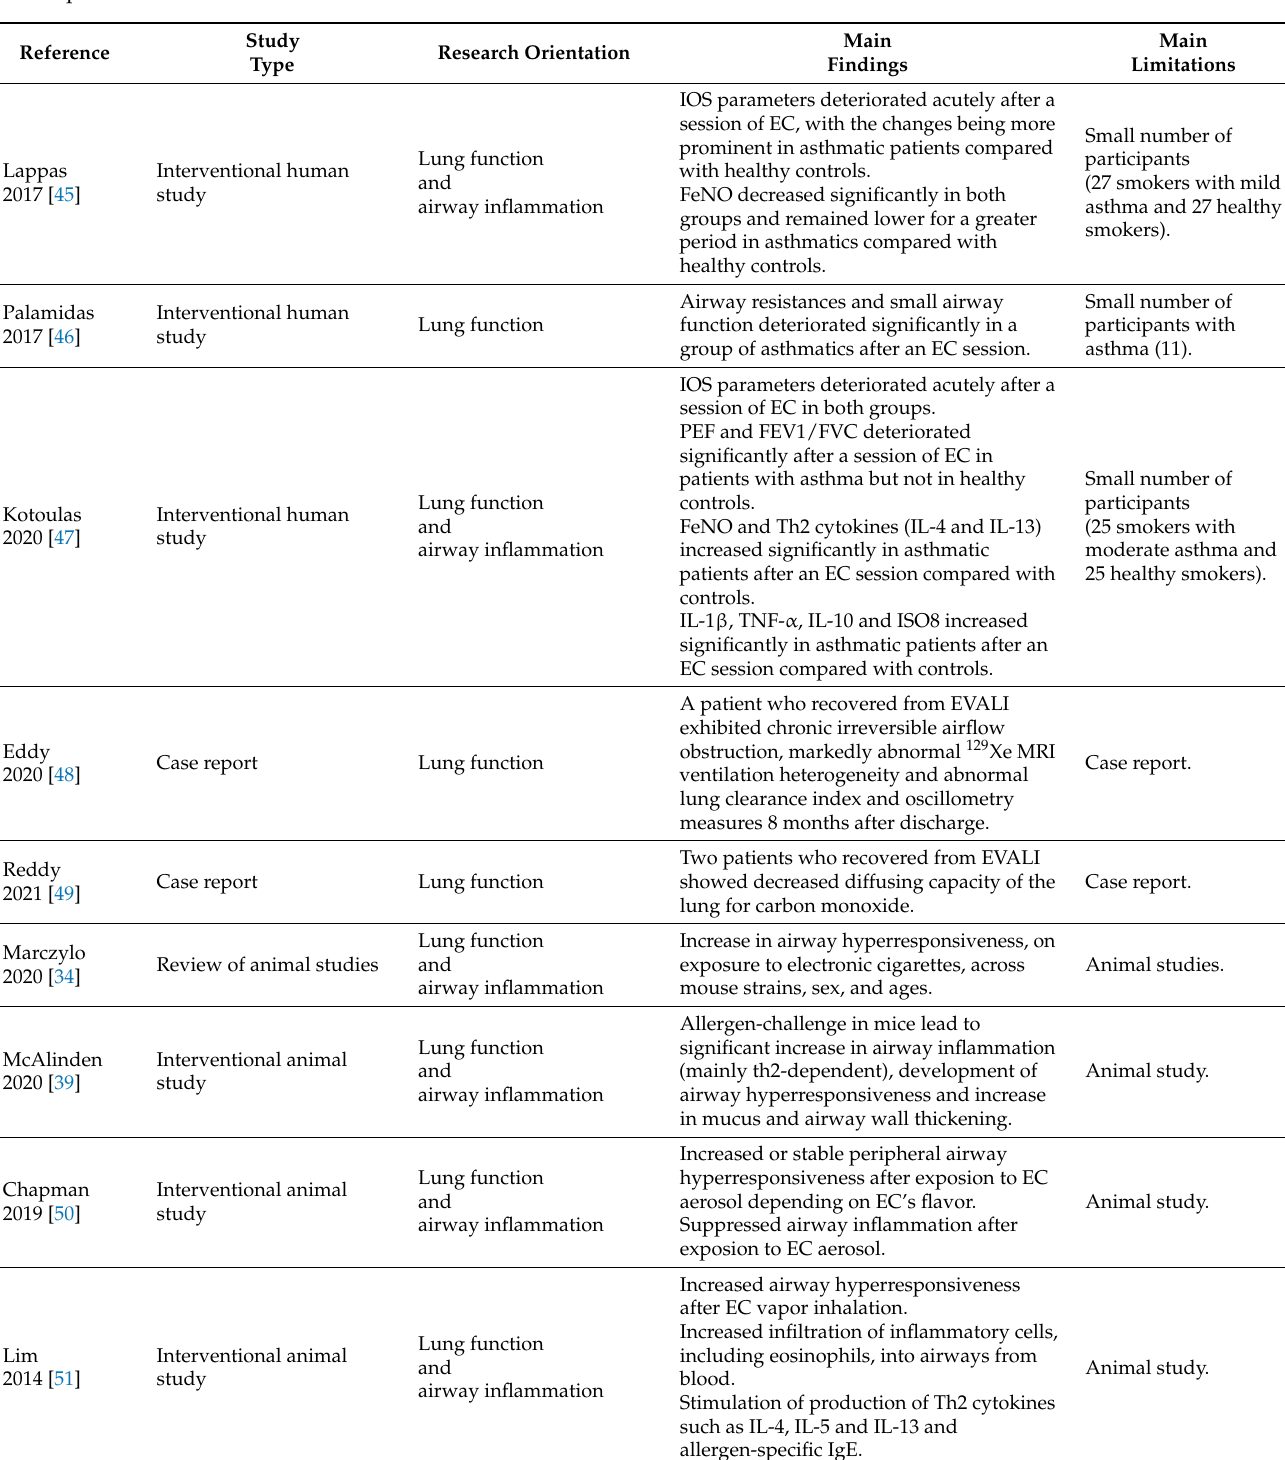
Table 1. Studies addressing research question 2: What is the effect of EC use on lung function and on airway inflammation in patients with